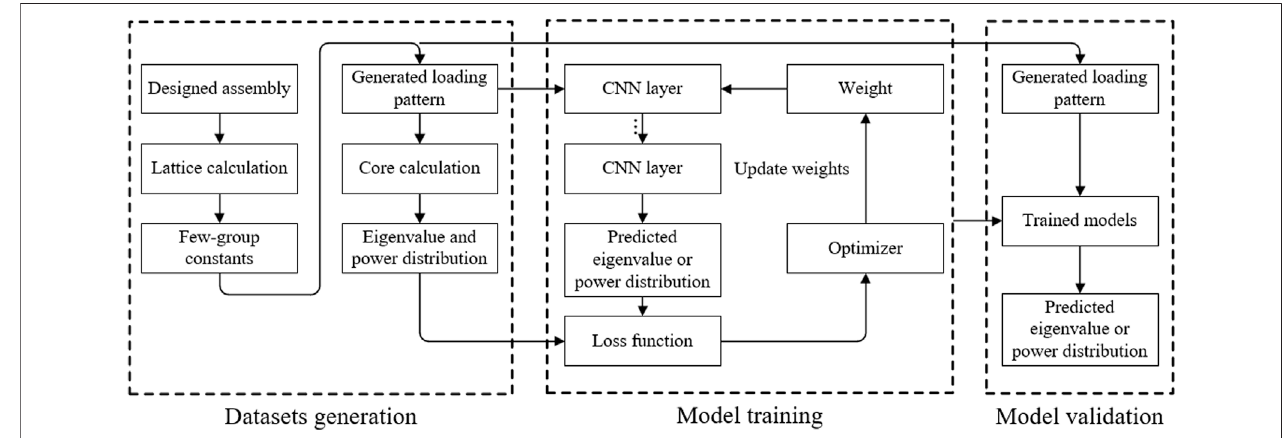
FIGURE 1 | Computing framework of core parameter prediction.